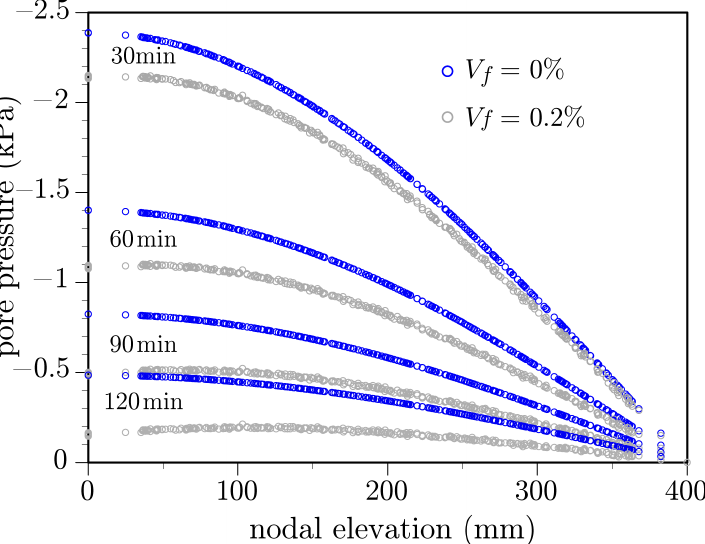
Figure 17. Influence of fiber dosage on the development of pore pressure distribution over time.